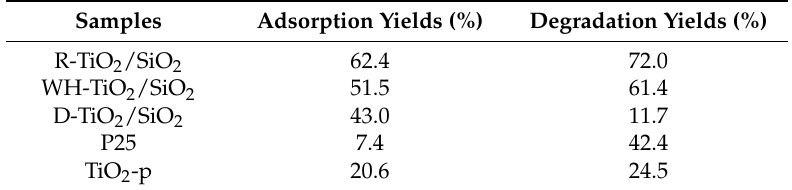
Table 3. Adsorption and degradation yields of gentian violet (GV) over the biotemplated samples and P25. Samples Adsorption Yields (%)